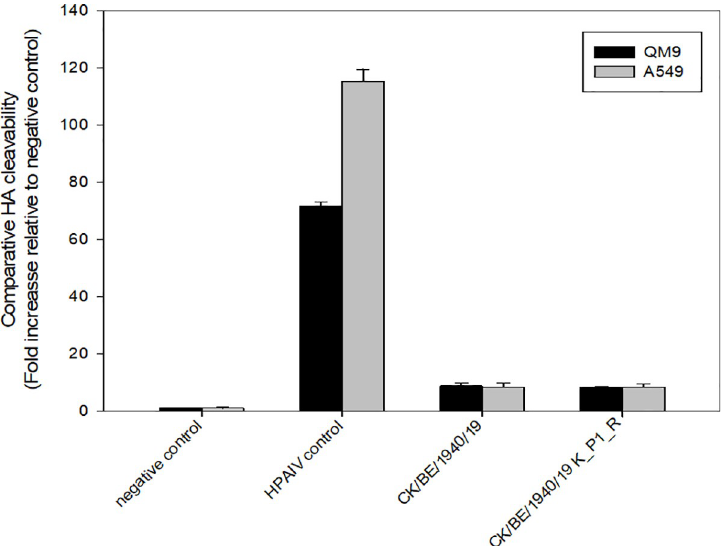
Fig 4. No furin cleavage of CK/BE/1940/19 (H3N1) HACS determined by luciferase reporter assay. Comparative cleavability of the hemagglutinin proteolytic cleavage site by furin or other intra-Golgi proteases, was determined by luciferase reporter assay in QM9 (avian) and A549 (human) cells. No signal was detected for the negative control, represented by a sequence with no HACS motif. For the HPAIV-derived polybasic HACS control a robust signal, more abundant in A549 cells, was generated. The CK/BE/1940/19 derived HACS, as well as a modified one with exchange of lysine at P1 against the more common arginine, did not induce signals indicating proteolytic processing.